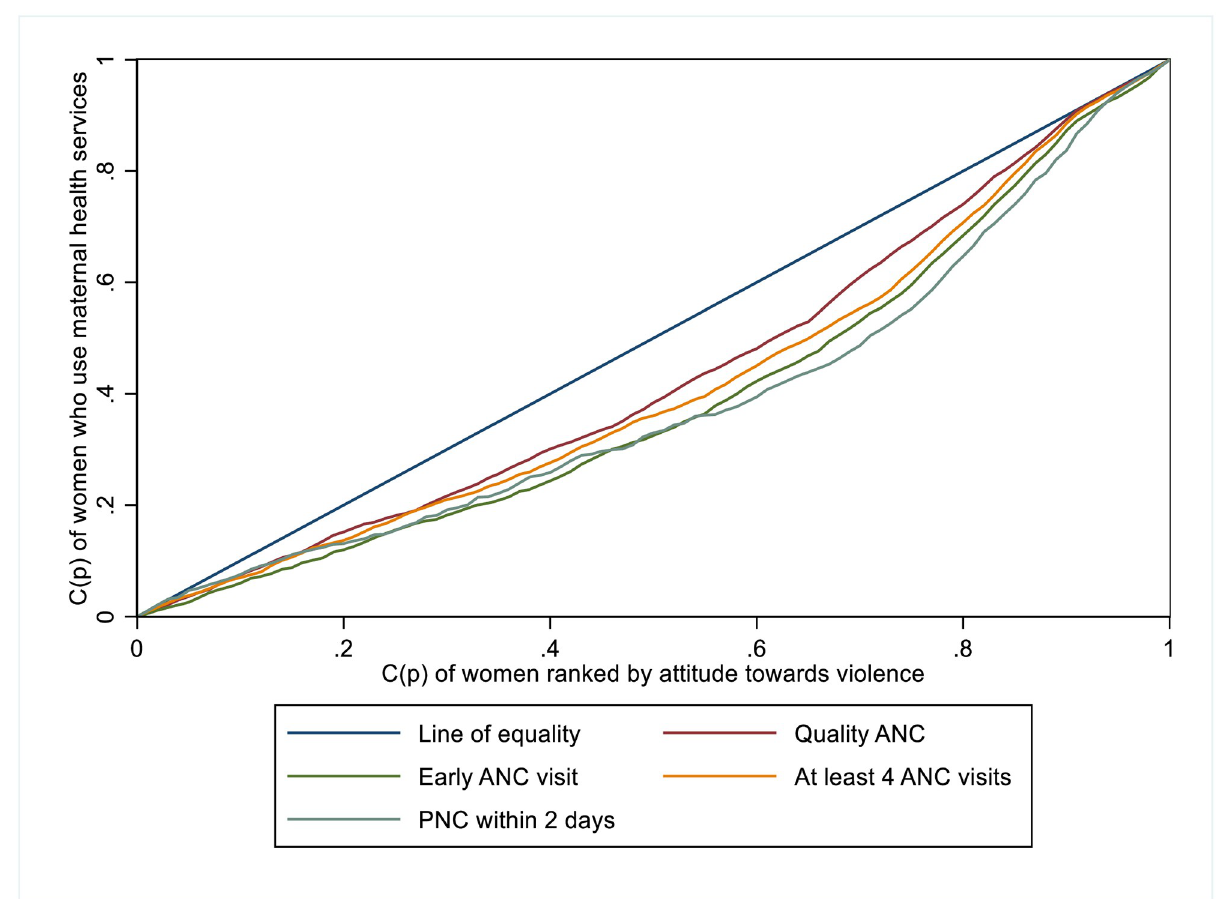
Fig 1. Concentration curves of maternal health services based on attitude towards violence domian of women’s empowerment. Note: C(p) refers to cumulative proportion.